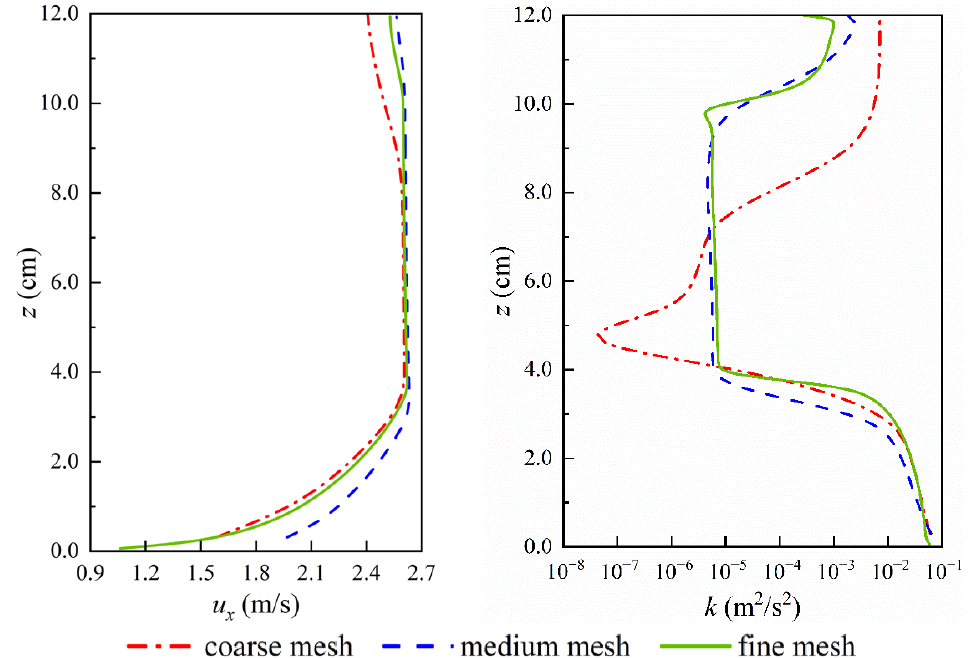
Figure A1. Vertical distributions of streamwise velocity u x and turbulent kinetic energy k in the middle longitudinal section at x = 112.5 cm.